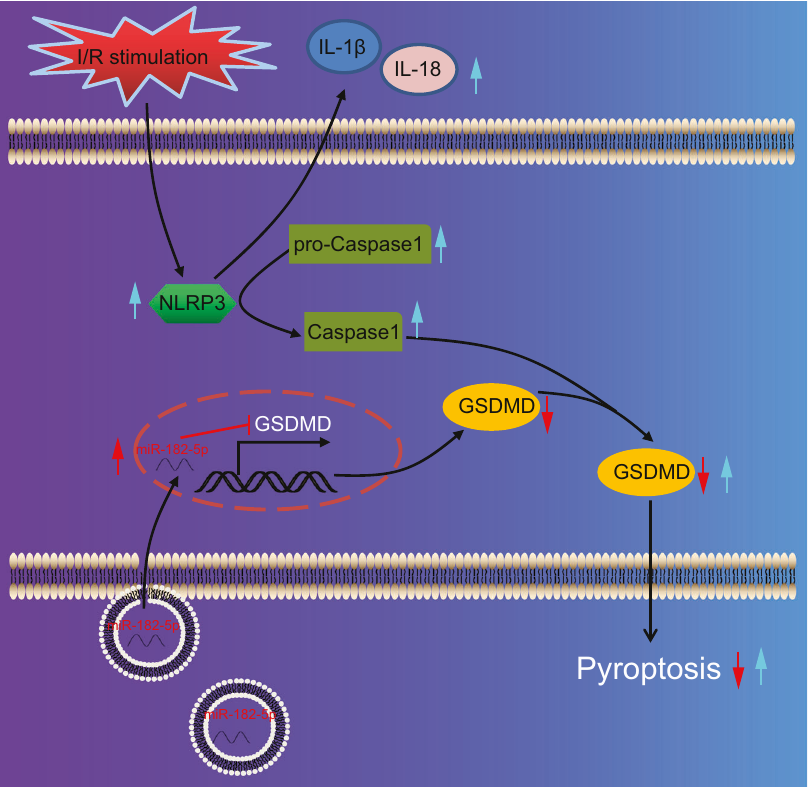
Fig. 8 A schematic diagram showing potential molecular mechanisms of exosomal miR-182-5p targeting GSDMD in myocardial I/R injury. miR-182-5p shuttled by exosomes from MSCs can be internalized by myocardial cells, and then targets GSDMD and reduces its expression, suppressing myocardial cell injury and pyroptosis, and delaying the myocardial I/R injury in